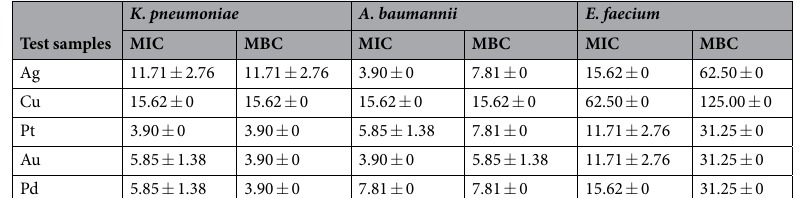
ver/palladium combination against E. faecium and silver/copper combination against A. baumannii demonstrated